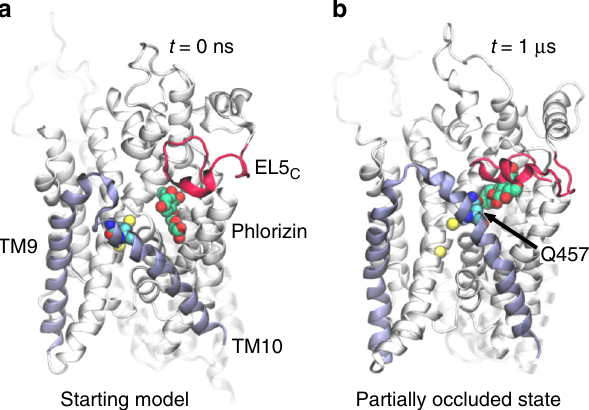
Fig. 3 Outer gate closure explains the impact of TM9-10 residues on substrate binding. a The outer gate residue Q457 on TM10 does not interact with phlorizin (green/red) in the outward-facing model of hSGLT1. b A molecular dynamics simulation of the hSGLT1 – phlorizin complex reveals signi fi cant movement in the TM9-10 outer gate bringing Q457 into direct contact with phlorizin. Additionally, EL5 C (red) closes over the top of the inhibitor. This fi gure is a snapshot from the trajectory at 1 μ s. Lipids and water are not shown for